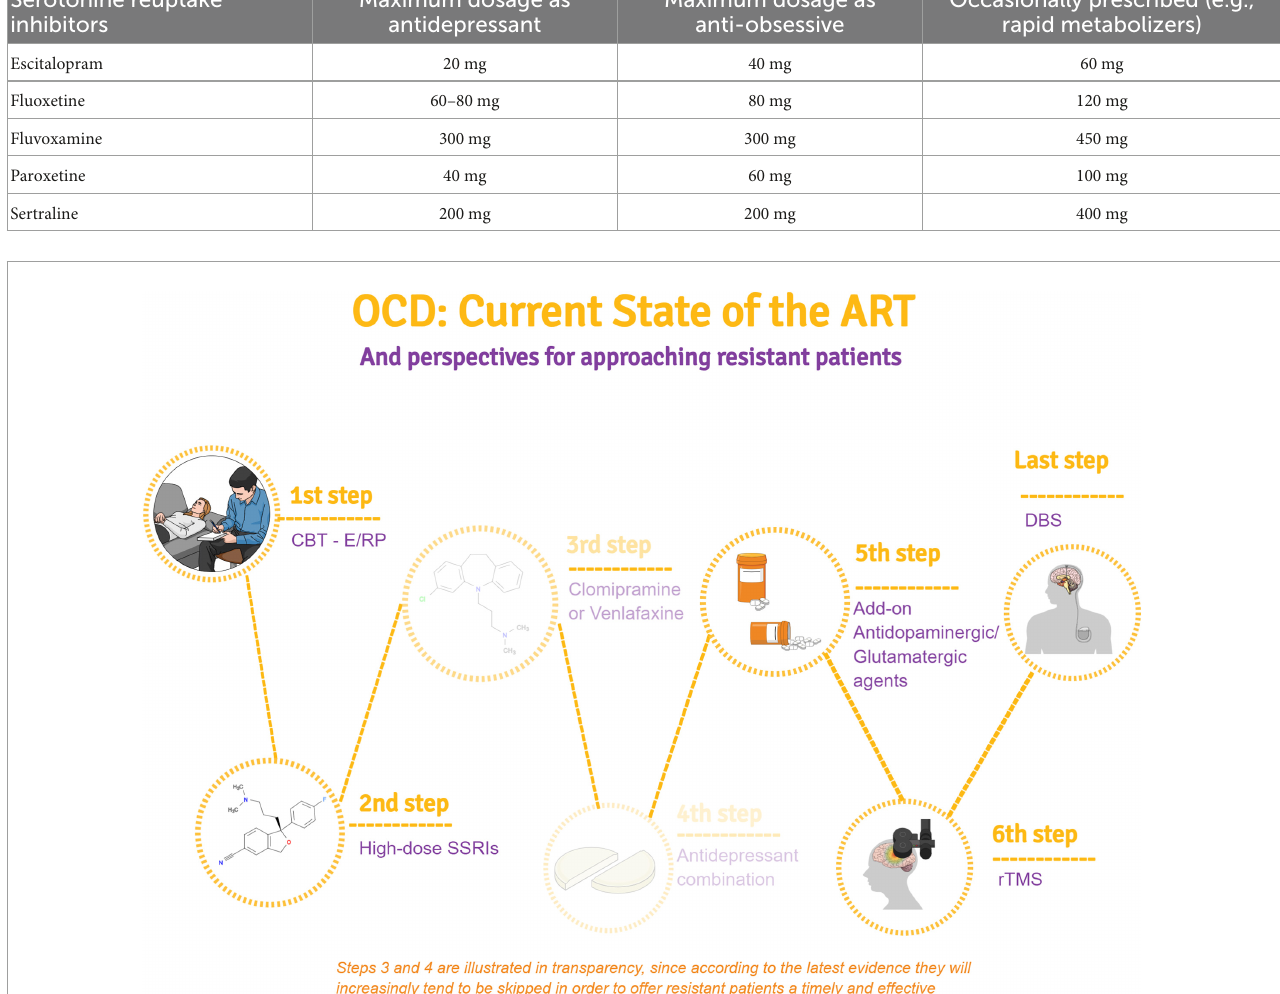
FIGURE1 A schematic summary of the various treatment steps according to the best evidence in the